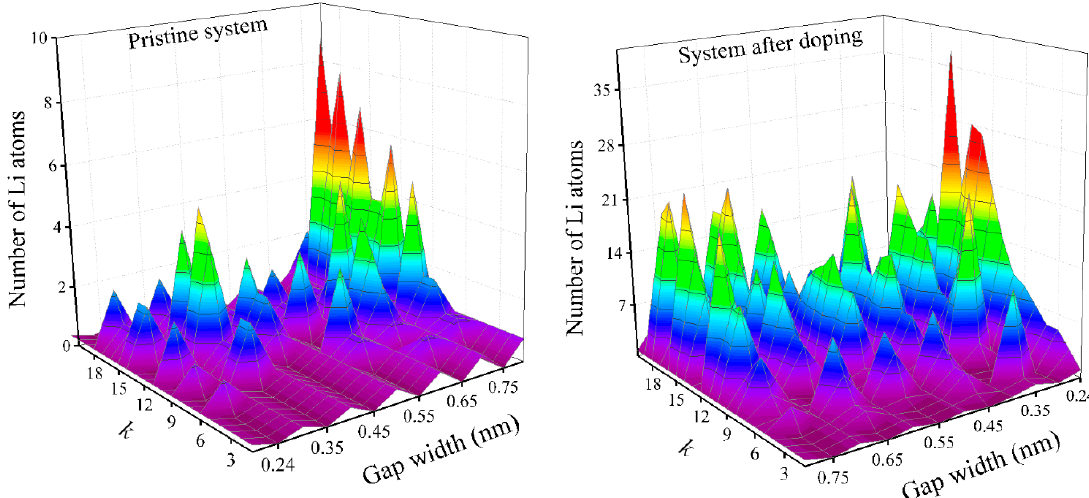
Figure 5. Vertical density profiles of lithium in the silicene channel obtained as a result of the intercalation of Li + ions into the channel (with walls of pristine silicene (left) and silicene processed by the NTD method (right)).